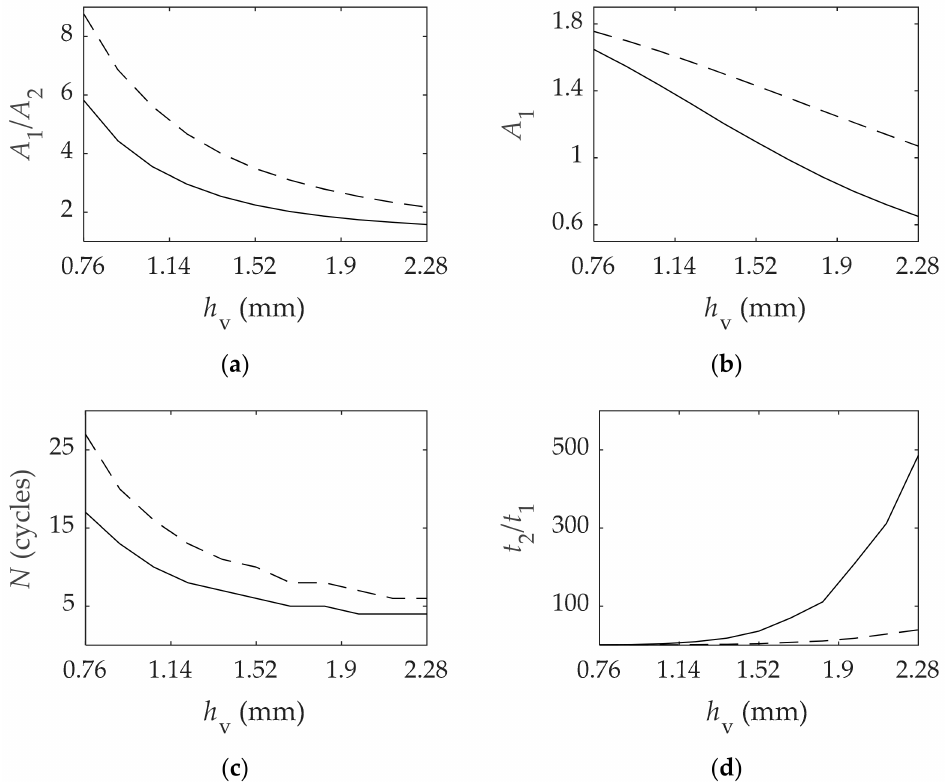
Figure 8. Influence of the viscoelastic layer thickness h v of the asymmetrical (